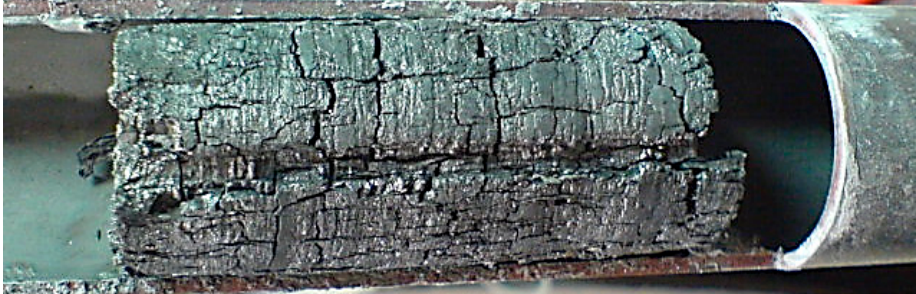
Figure 8. The coal sample after the experiment in the gasification reactor.